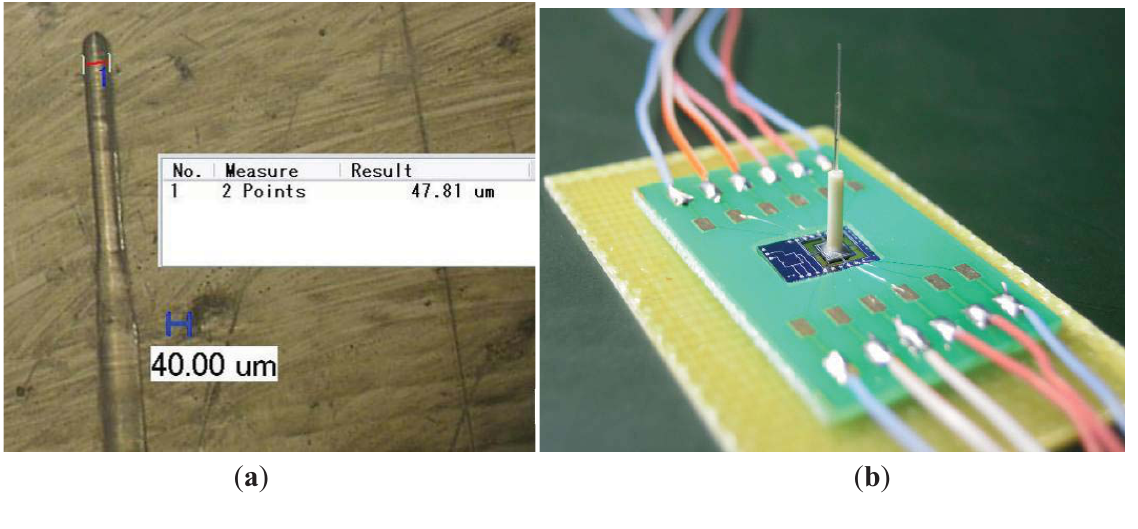
Figure 7. The pictures of the finished sensor. ( a ) The digital microscopy of finished probe tip; ( b ) The digital photograph of the finished